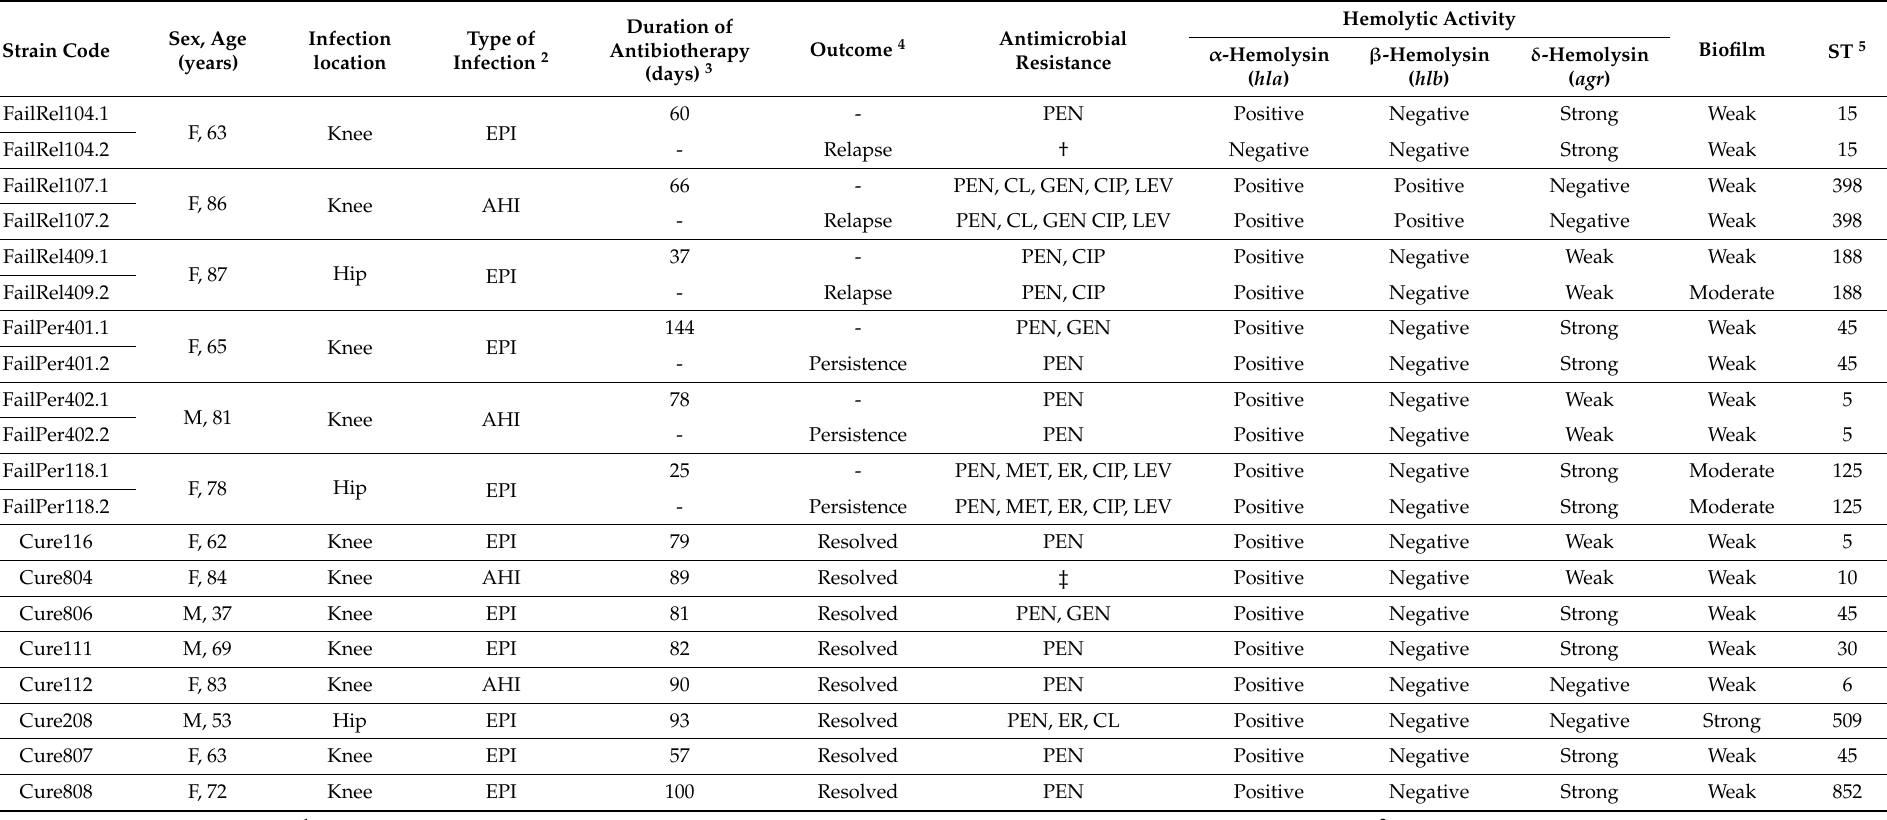
Table 1. Clinical and microbiological characteristics of recurrent (persistence and relapse) and resolved prosthetic joint infection cases included in this study 1